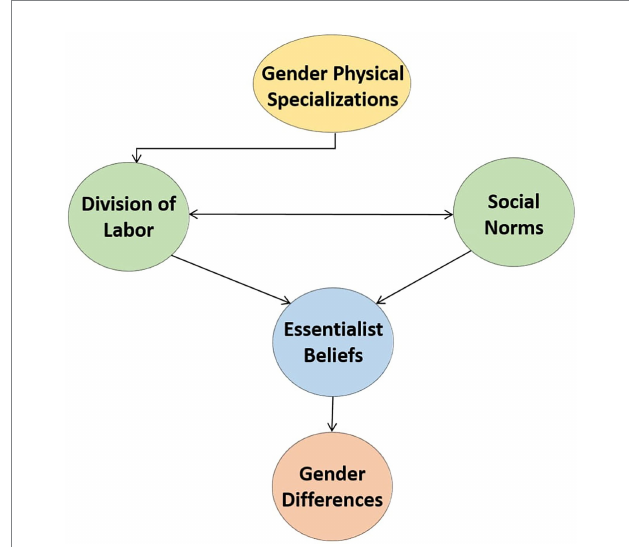
FIGURE 1 Overview of social-role theories of gender differences. Gender differences are generated by essentialist beliefs that men and women are intrinsically different which are in turn influenced by social norms in tandem with the division of labor derived from gender physical